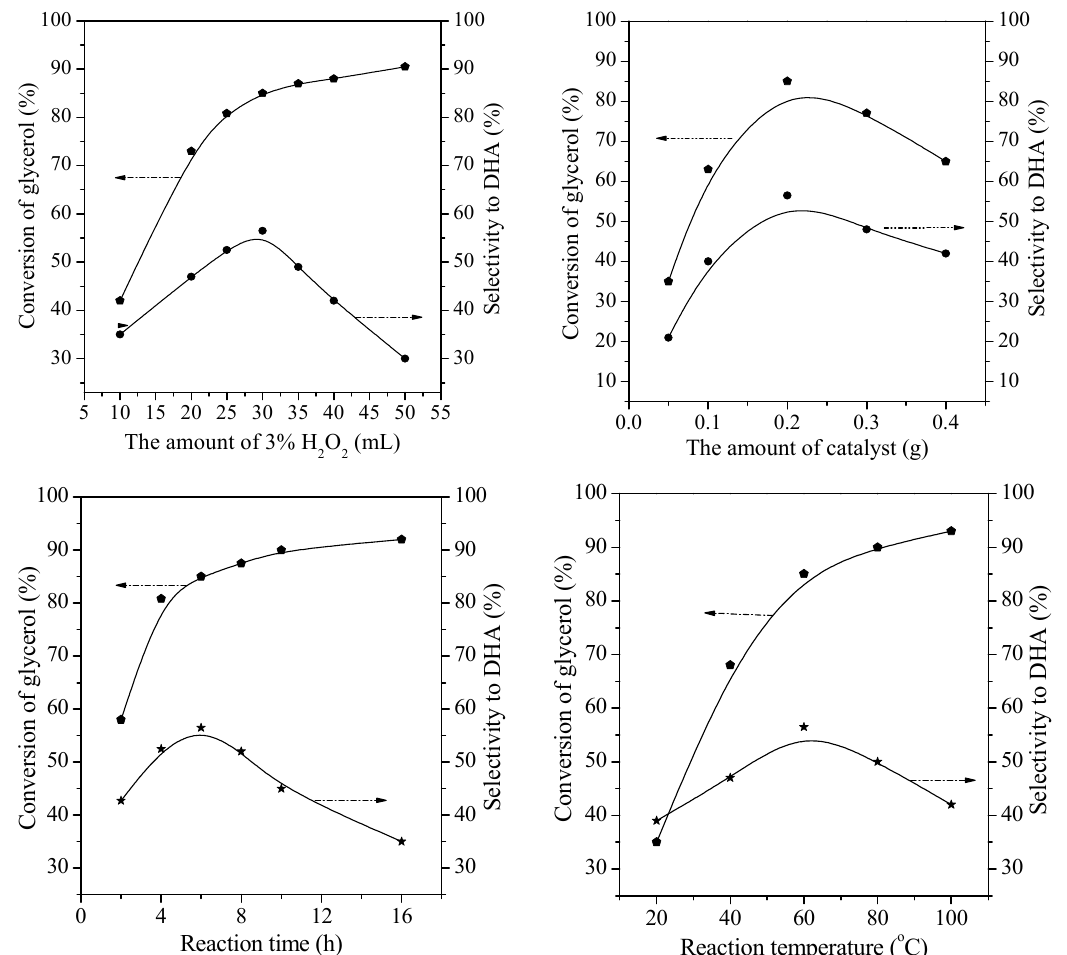
Figure 6. Effect of the reaction conditions on the catalytic performance of LDH ‐ [Cr(SO 3 ‐ salphen)].